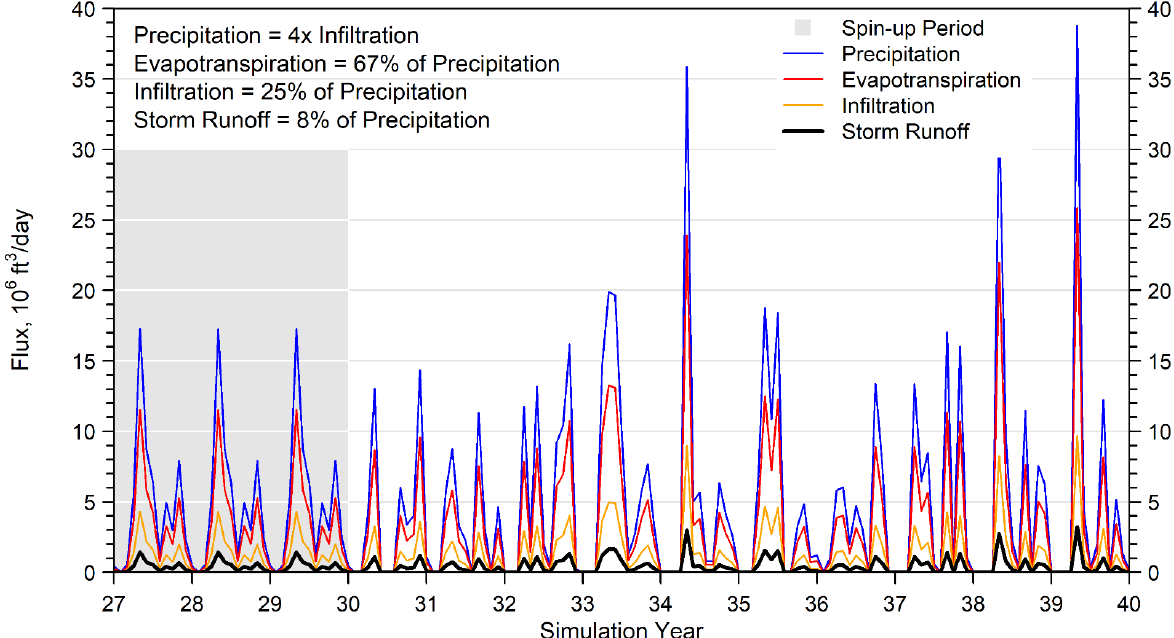
Figure 5. Flux terms for an example basin showing assumed relationships of precipitation, evapotranspiration, and storm runoff with infiltration rate at the end of the spin-up and warming periods. The absolute fluxes correspond to amounts for basin contributing runoff to an example stream segment (see Supplementary Material Figure S2-3a for the location of the basin comprising Segment 1 in the synthetic model). Warming begins in Simulation Year 30.